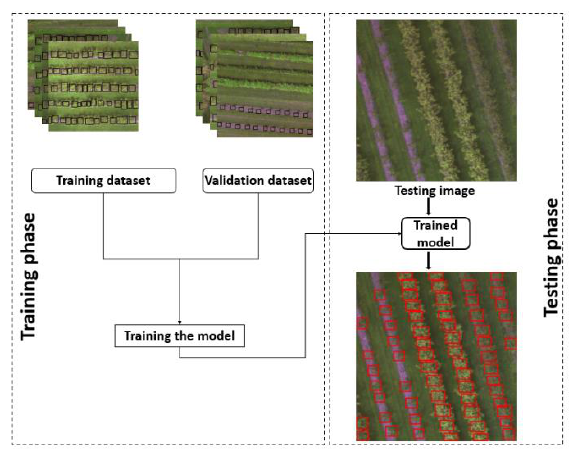
Figure 3 . Flowchart of the methodology used in the study.